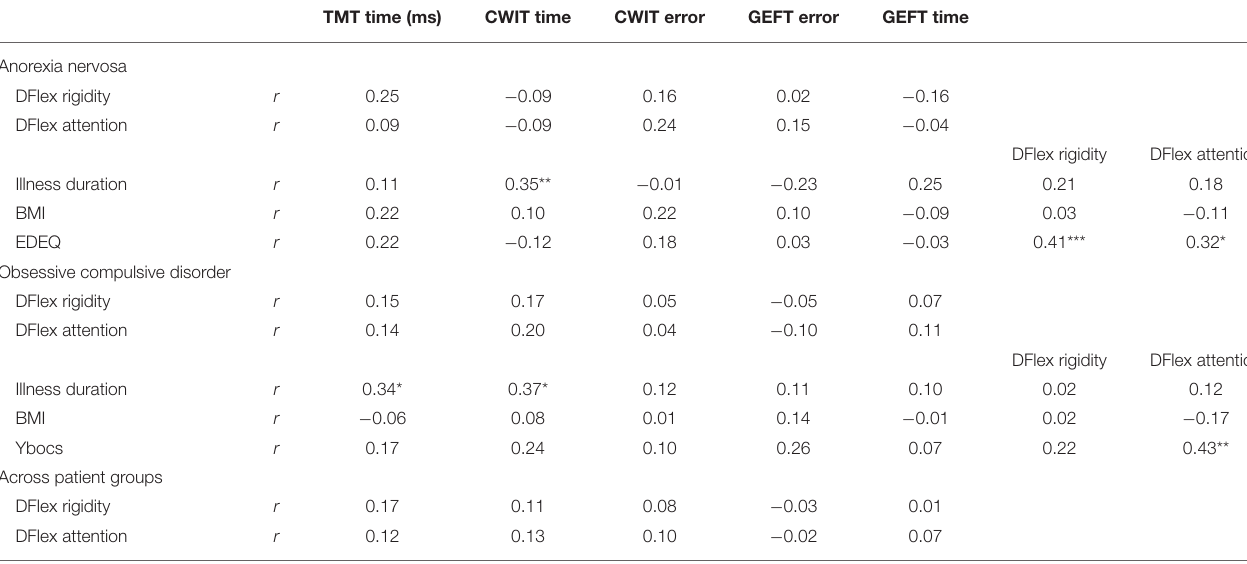
TABLE 2 | Partial correlations adjusting for age for the anorexia nervosa and obsessive compulsive disorder groups separately and together between the self-report measures of flexibility (DFlex) and the different set-shifting (TMT and CWIT) and central coherence (GEFT) measures. TMT time